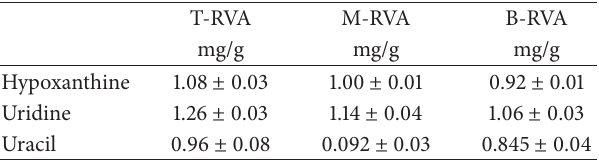
Table 2: Hypoxanthine, uridine, and uracil contents of regrowth velvet antler extracts.